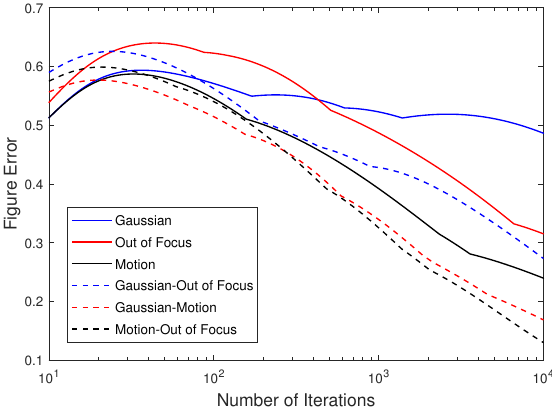
Figure 34. Figure error plots of the proposed algorithm in all cases of RGB images.